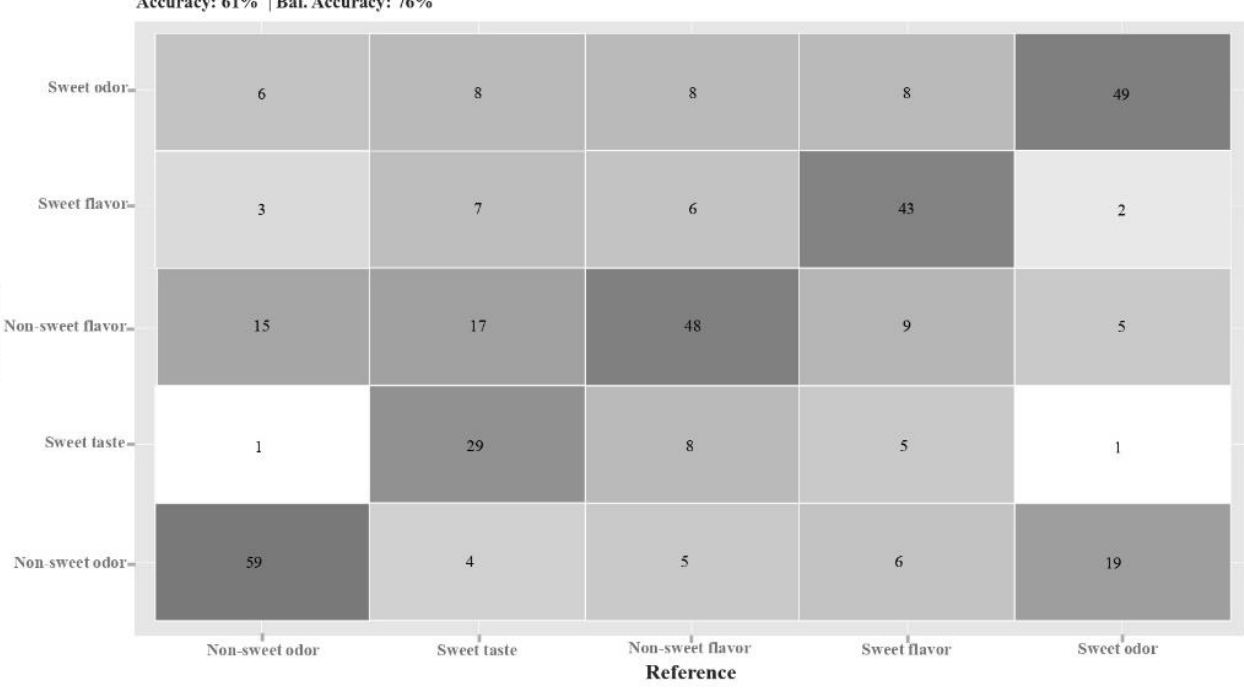
Figure 5. Confusion matrix of the descriptive model shown in Figure 4.